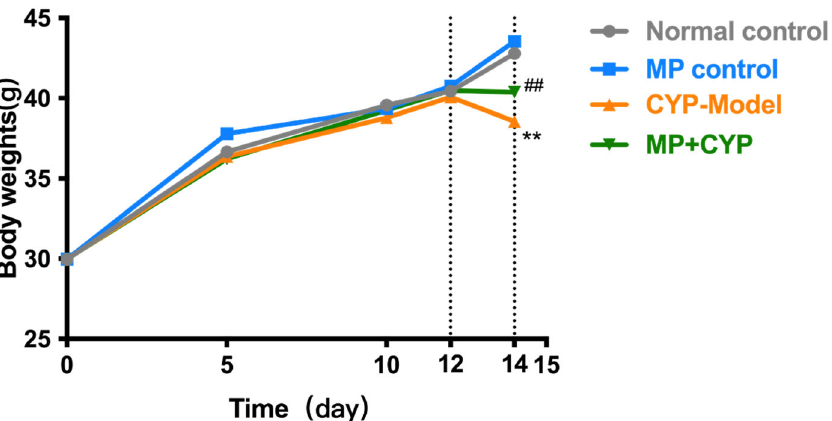
Figure 2. Effects of Maca polysaccharide on body weight of normal and CYP ‐ treated mice ( n = 12). Compared with Normal Control group: ** p < 0.01; Compared with CYP Model group: ## p < 0.01. Data are expressed as means ± SEM.